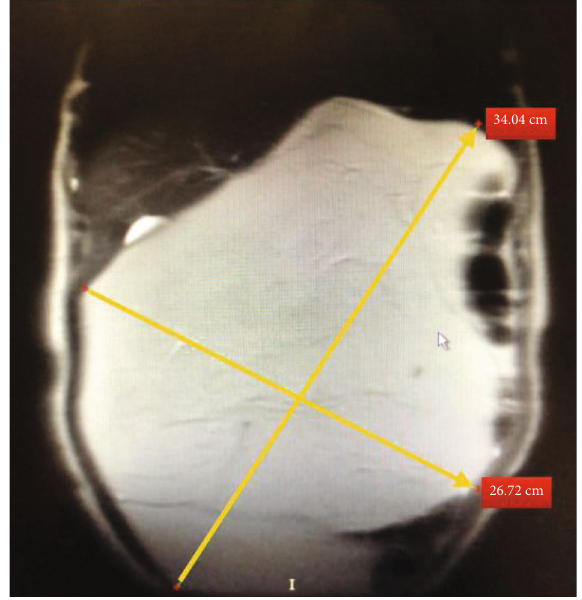
Figure 4: It was reported that the long diameter of the pathology specimen was measured as 40cm.